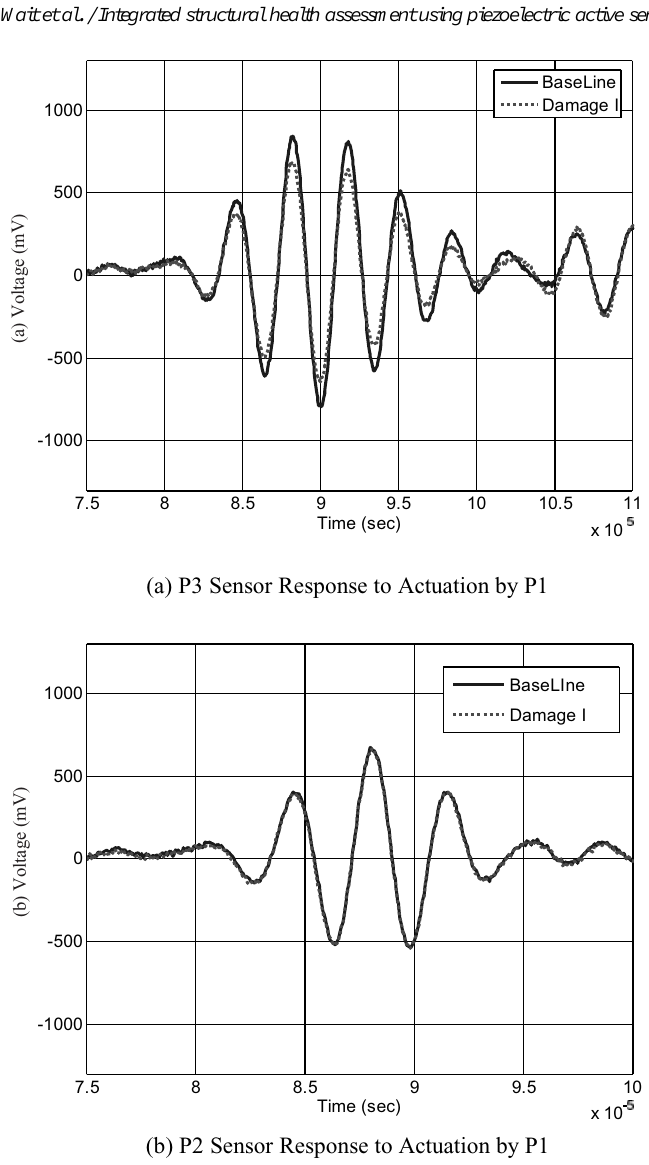
Fig. 11. The First arrival of A 0 modes (a) P3 Sensor Response to Actuation by P1; (b) P2 Sensor Response to Actuation by